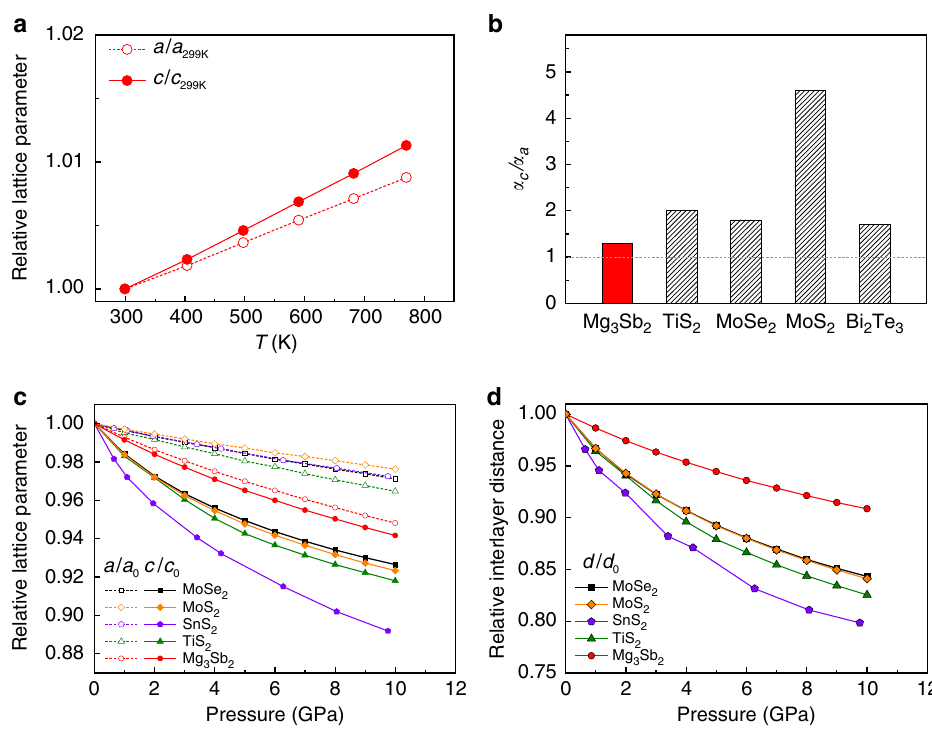
Fig. 3 Lattice thermal expansion and pressure compression. a Relative lattice constants a / a 299K and c / c 299K of Mg 3 Sb 2 as a function of temperature. The data are obtained from Rietveld re fi nement of the multi-temperature synchrotron PXRD. b Anisotropic ratio of the linear thermal expansion coef fi cient α c / α a in Mg 3 Sb 2 compared to those of several typical layered materials, that is, TiS 2 32 , MoSe 2 33 , MoS 2 33 , and Bi 2 Te 3 34 . c , d The calculated pressure dependence of ( c ) the relative lattice parameters and ( d ) the relative interlayer distance of Mg 3 Sb 2 in comparison with those of several typical layered metal dichalcogenides. The data of SnS 2 are adapted from the reported experimental work